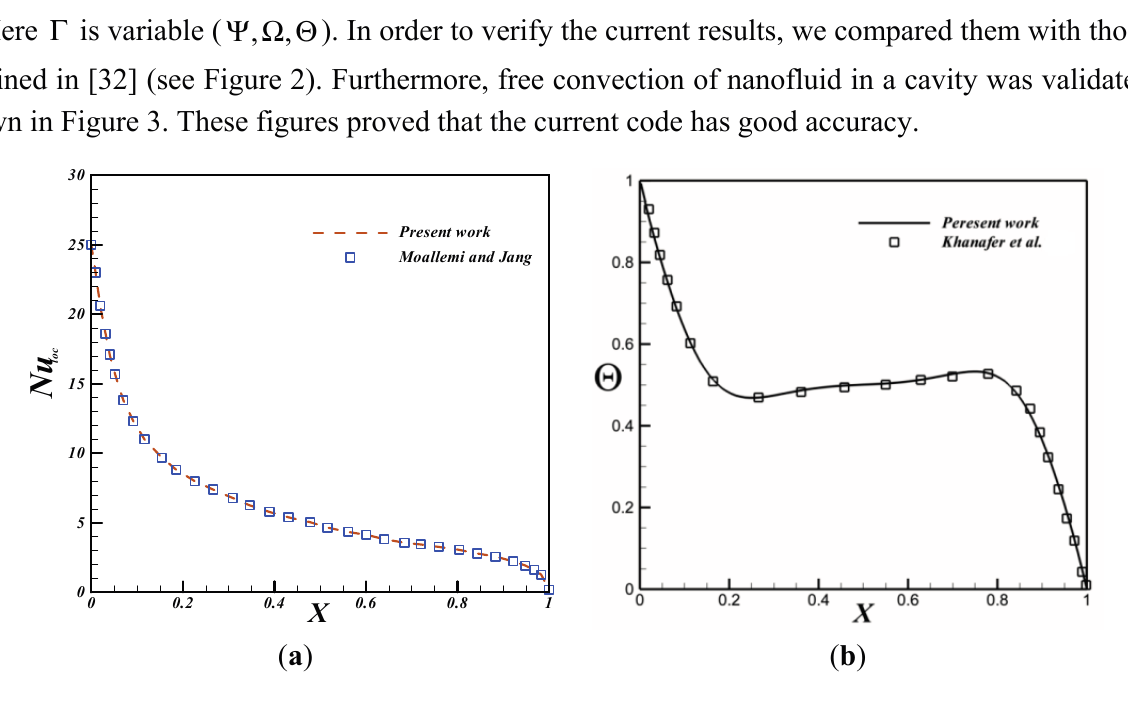
Figure 3. ( a ) Comparison of the local Nusselt number over the lid wall between the present results and Moallemi and Jang [30] at Re = 500, Ri = 0.4, and Pr = 1; ( b ) Comparison of average Nusselt number between the present results and numerical results by Khanafer et al.